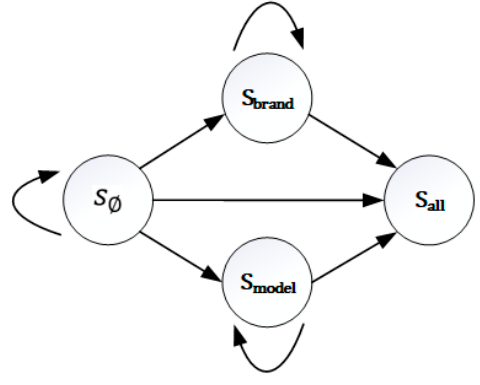
Figure 6. Identification state transition diagram.